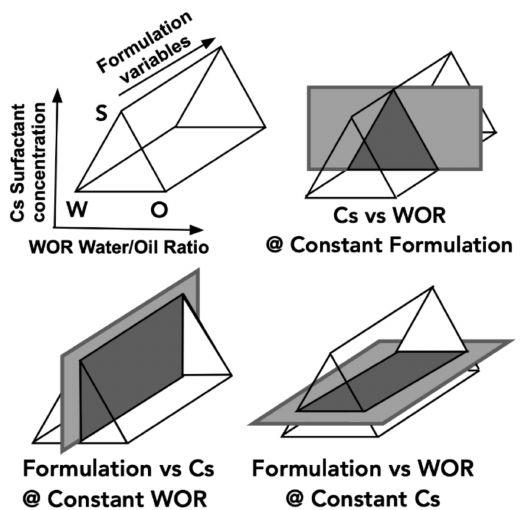
Figure 4. The three-dimensional way to handle the description of a SOW system as a function of the generalized formulation hydrophilic-lipophilic deviation (HLD), as well as constant surfactant concentration (Cs) and water-to-oil ratio (WOR). There are three types of 2D cuts at constant formulation, constant WOR = 1, and constant concentration of surfactant Cs.